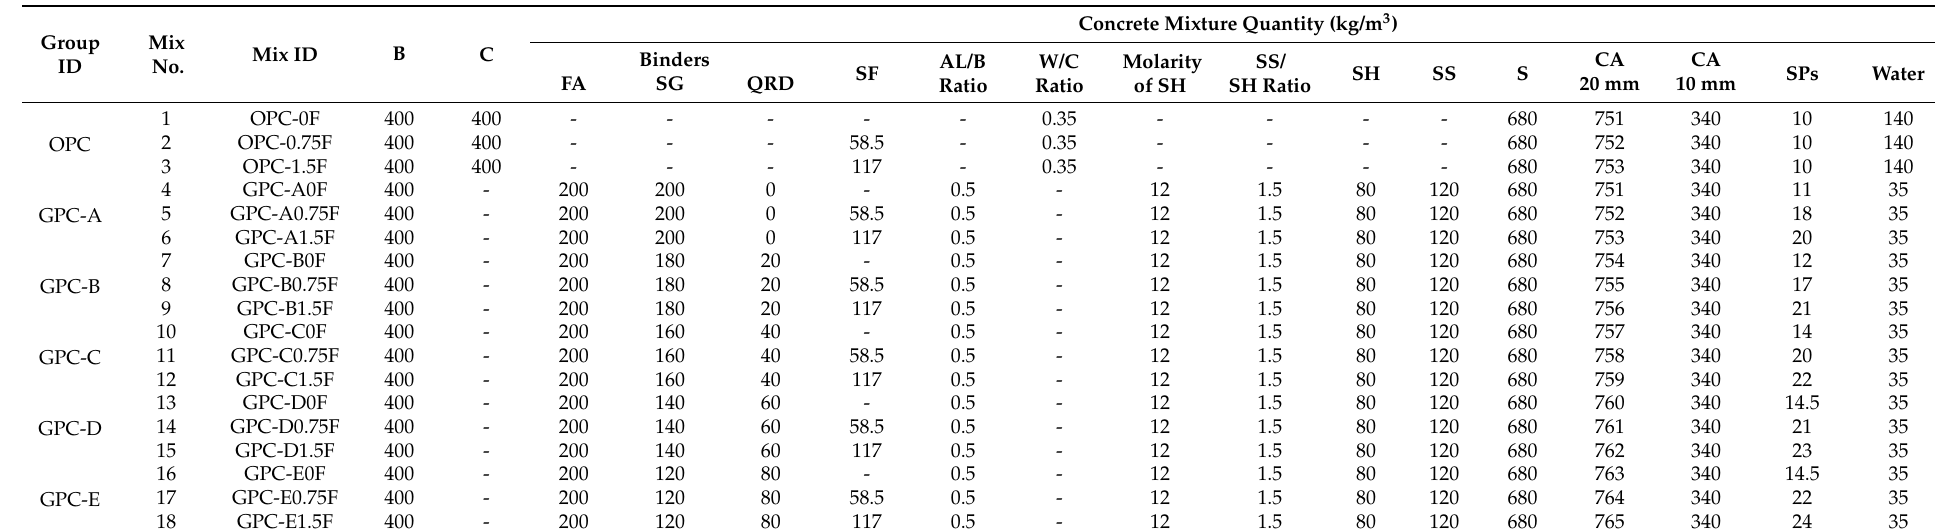
Table 7. The detail of mix proportions of OPC and GPC